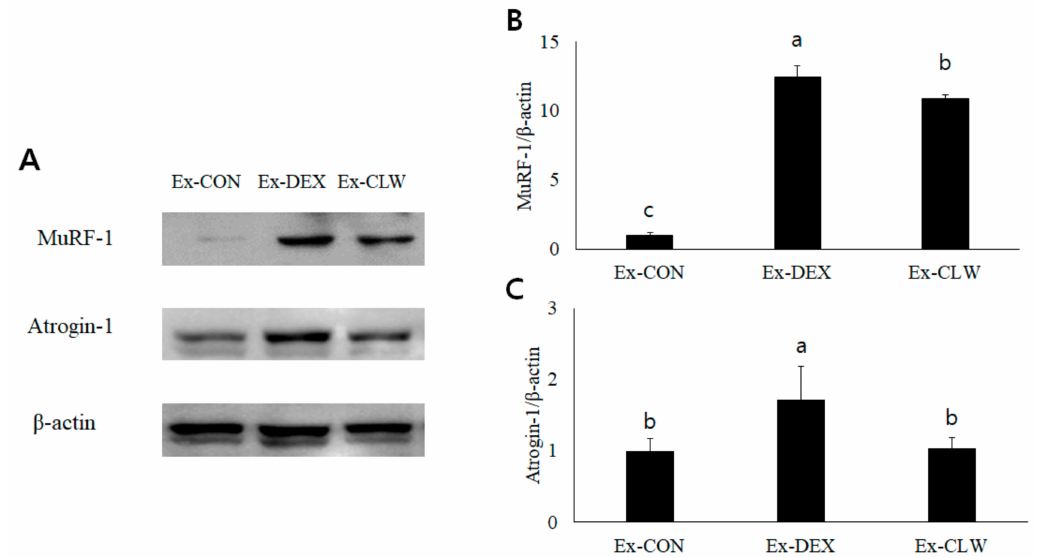
Figure 4. Effect of CLW on MuRF-1 and Atrogin-1 in mice with DEX-induced muscle atrophy. ( A ) MuRF-1 and Atrogin-1 were analyzed by Western blotting. ( B , C ) Relative density was calculated as the ratio of MuRF-1 and Atrogin-1 expression to β -actin expression. Ex-CON, DW supplementation, and saline IP injection group; Ex-DEX, DW supplementation, and DEX (1 mg/body weight/day) IP injection group; Ex-CLW, CLW supplementation (1 g/body weight/day), and DEX IP injection group. Data are expressed as mean ± SE for eight mice in each group. Values with different superscripts indicate a significant difference among groups based on Duncan’s multiple range test ( p <